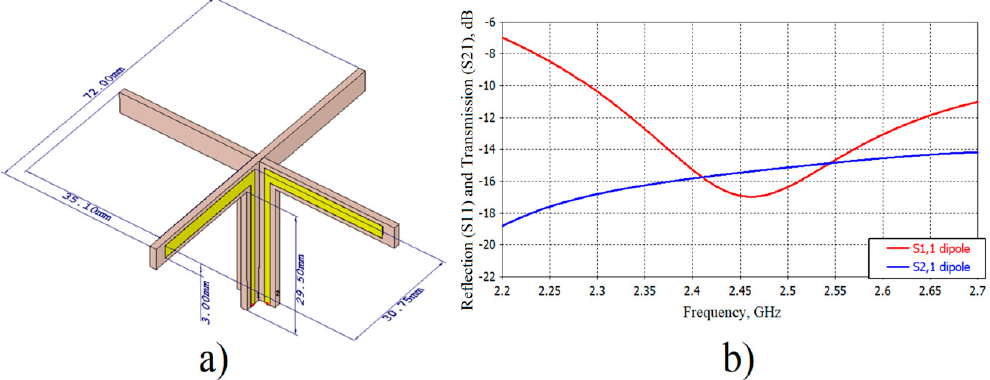
Figure 2. ( a ) Cross-dipole antenna design with dimension parameters and ( b ) Simulated results for S 11 , S 21.